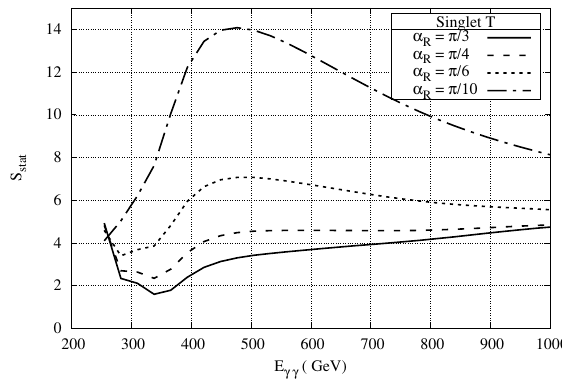
Figure 13 . Statistical Sensitivity as a function of γγ collider energy for the process γγ → hh in the model with an additional singlet Top partner. The benchmark point parameters are given as Benchmark 1 in table